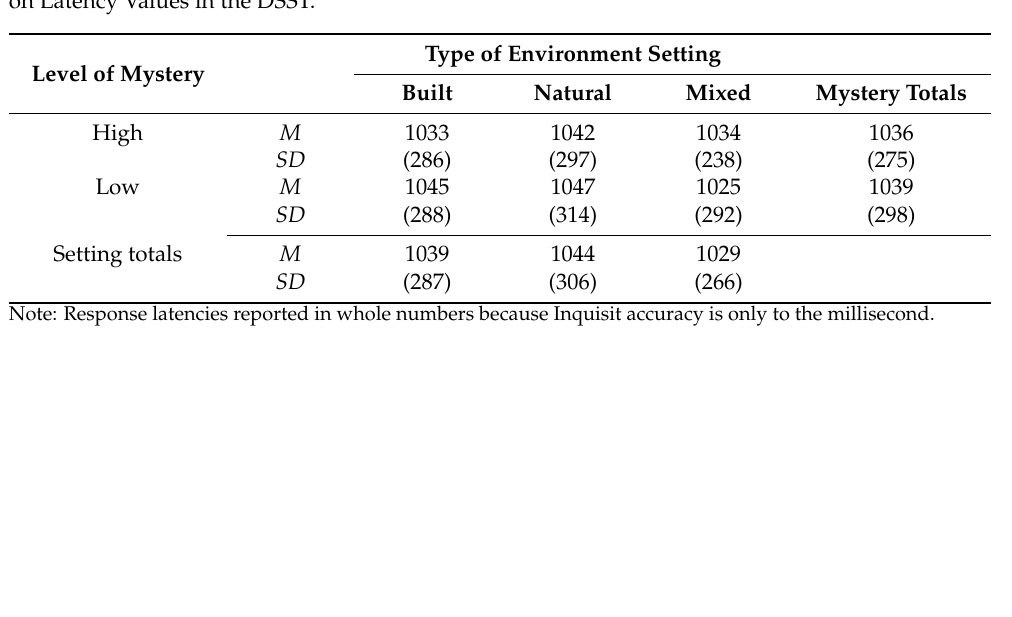
Table 4. Post-Transformation Descriptive Statistics for the Effect of Mystery and Environment Settings on Latency Values in the